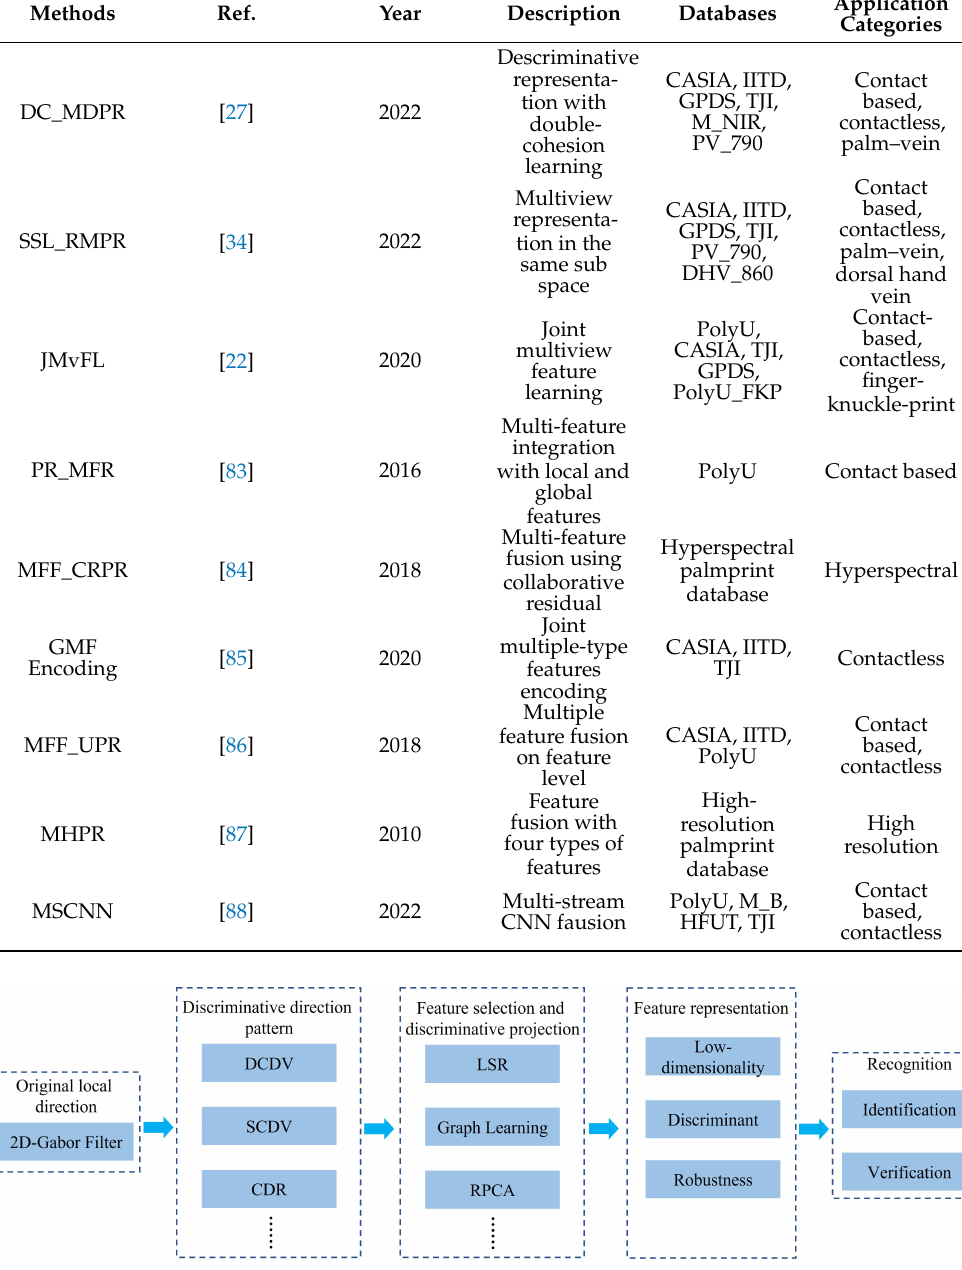
Figure 8. The pipleline of the multiview palmprint feature learning